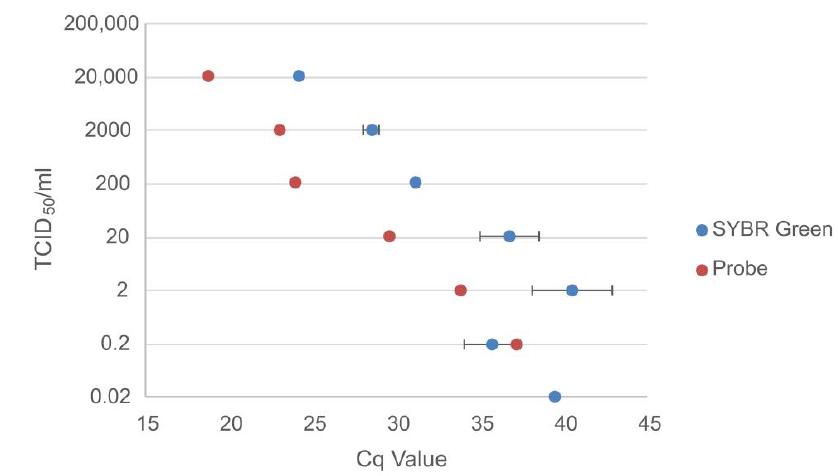
Figure 8. Comparison of the Cq values for the probe-based assay and the average Cq values for the SYBR Green assay for negative bat sera spiked with the titrated (TCID 50 /mL) serially diluted Margburg virus.